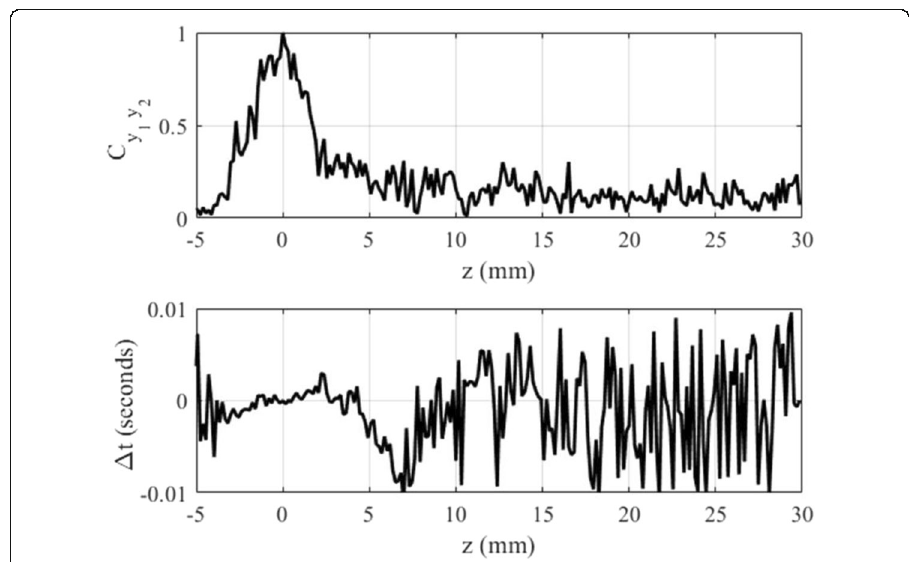
Fig. 20 Magnitude squared coherence and time lag value, as they vary with location associated with y 1 , at frequency of 40 Hz, where y 1 is located on a line and y 2 is positioned at one shock wave location, for data acquired on 05 April 2018. Positive values of time lag indicate that perturbations which originate at line locations occur prior to events which occur at the single shock wave